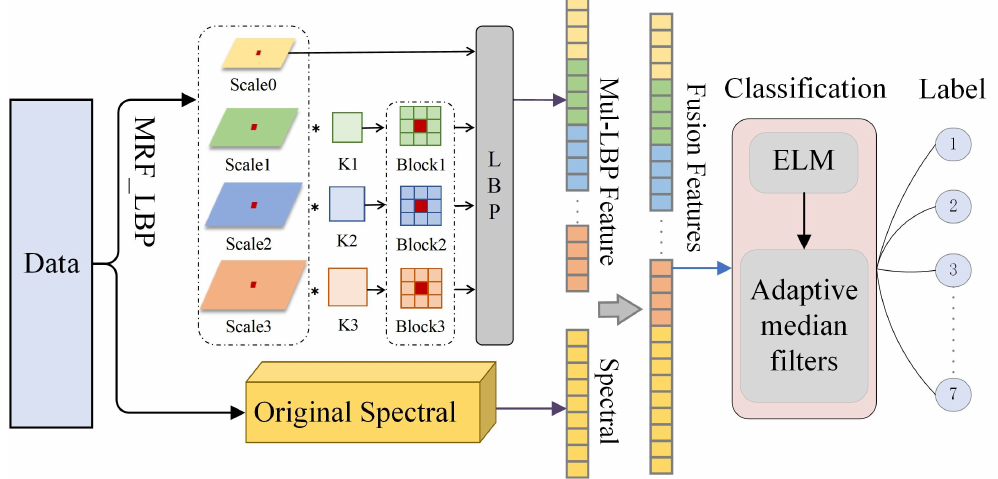
Figure 10. The classification frame of the fusion of spatial-spectral